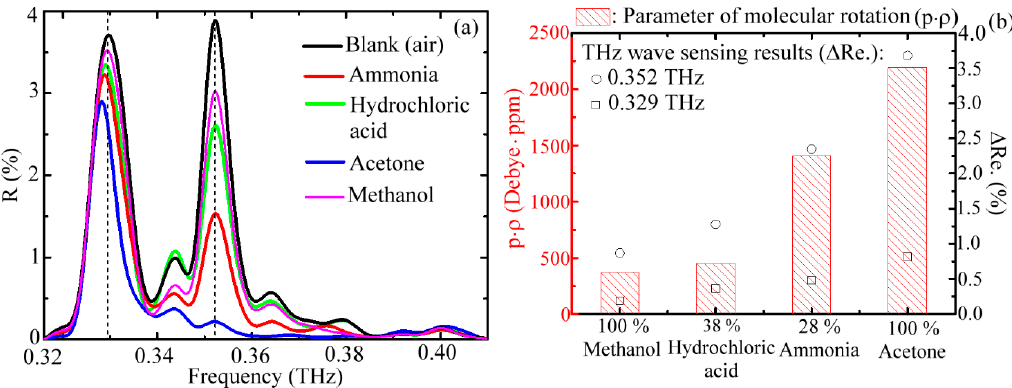
Figure 6. ( a ) Reflectivity spectra of a WGS unit for blank condition and loading various vapors, and ( b ) THz response in terms of Δ Re. at the 0.329 THz and 0.352 THz frequencies for different vapors with various molecular rotation abilities represented by p × ρ